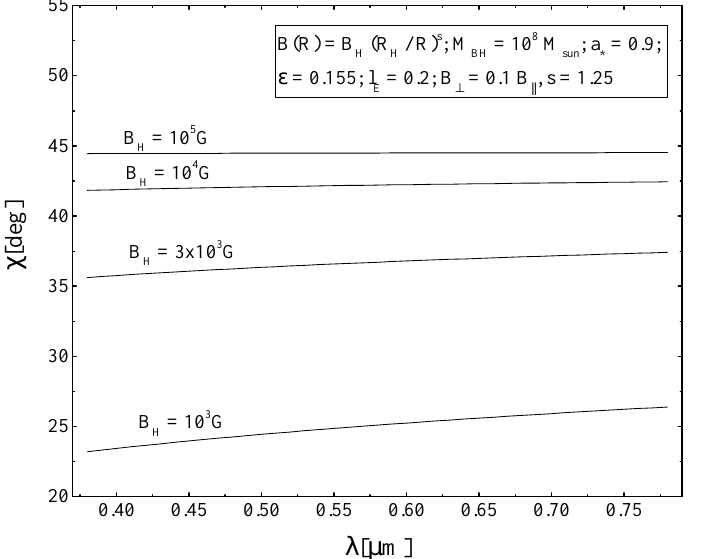
Figure 6. Dependence of the positional angle χ on the wavelength λ for different values of the parameter B H